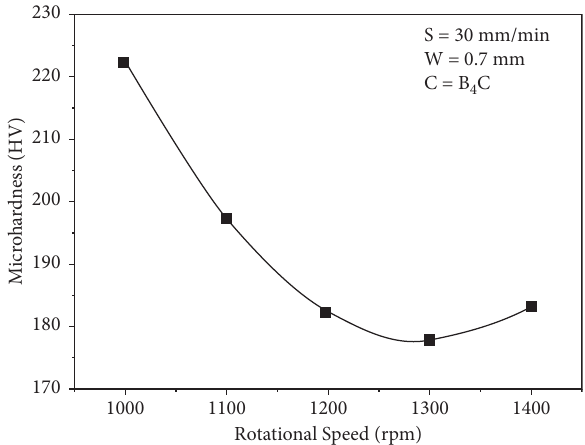
Figure 16: Variations in microhardness as a function of tool rotational speed.